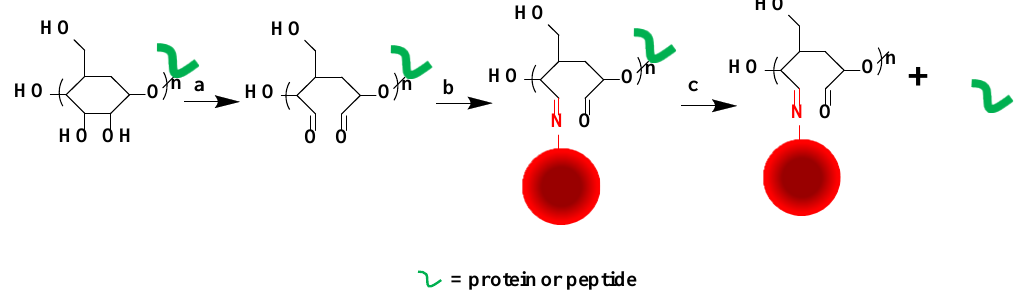
Scheme 3. Mechanism of glycoprotein and glycopeptide enrichment with magnetic